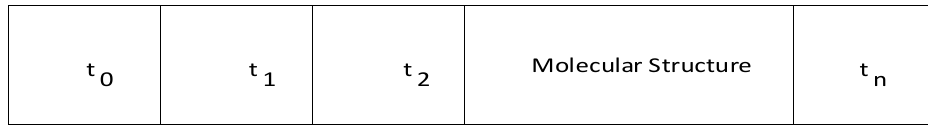
Figure 4. The demonstration of molecular structure.